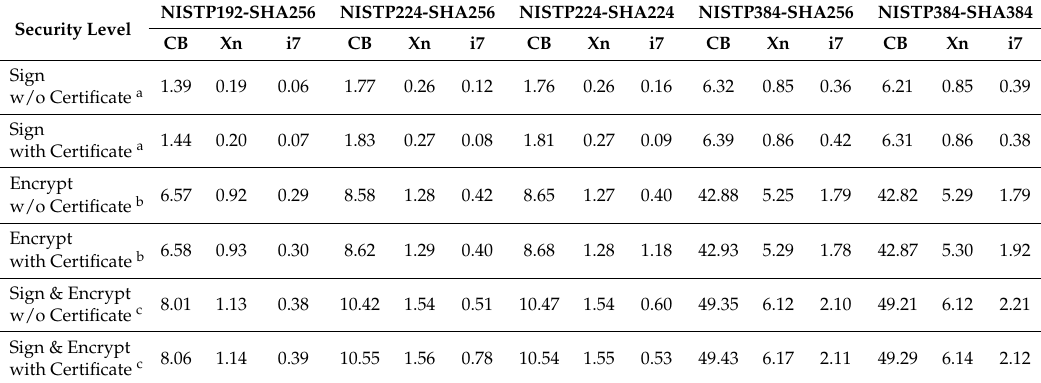
Sign & Encrypt 8.01 1.13 w/o Certificate c Sign & Encrypt 8.06 1.14 with Certificate c a Messages are digitally signed using ECDSA; b Messages are encrypted using ECIES with AES; c Messages are encrypted using ECIES with AES and digitally signed using ECDSA. Table 5. DECAP Delay in milliseconds (ms) for different cryptographic schema on CubieBoard (CB), Intel Xeon (Xn) and Intel i7 (i7) processors, using the AES-CCM algorithm with 128 bits keys. Security Level